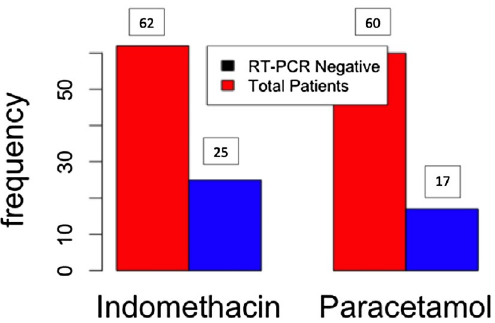
Figure 6. RT-PCR results at seventh day in both treatment and control arms.